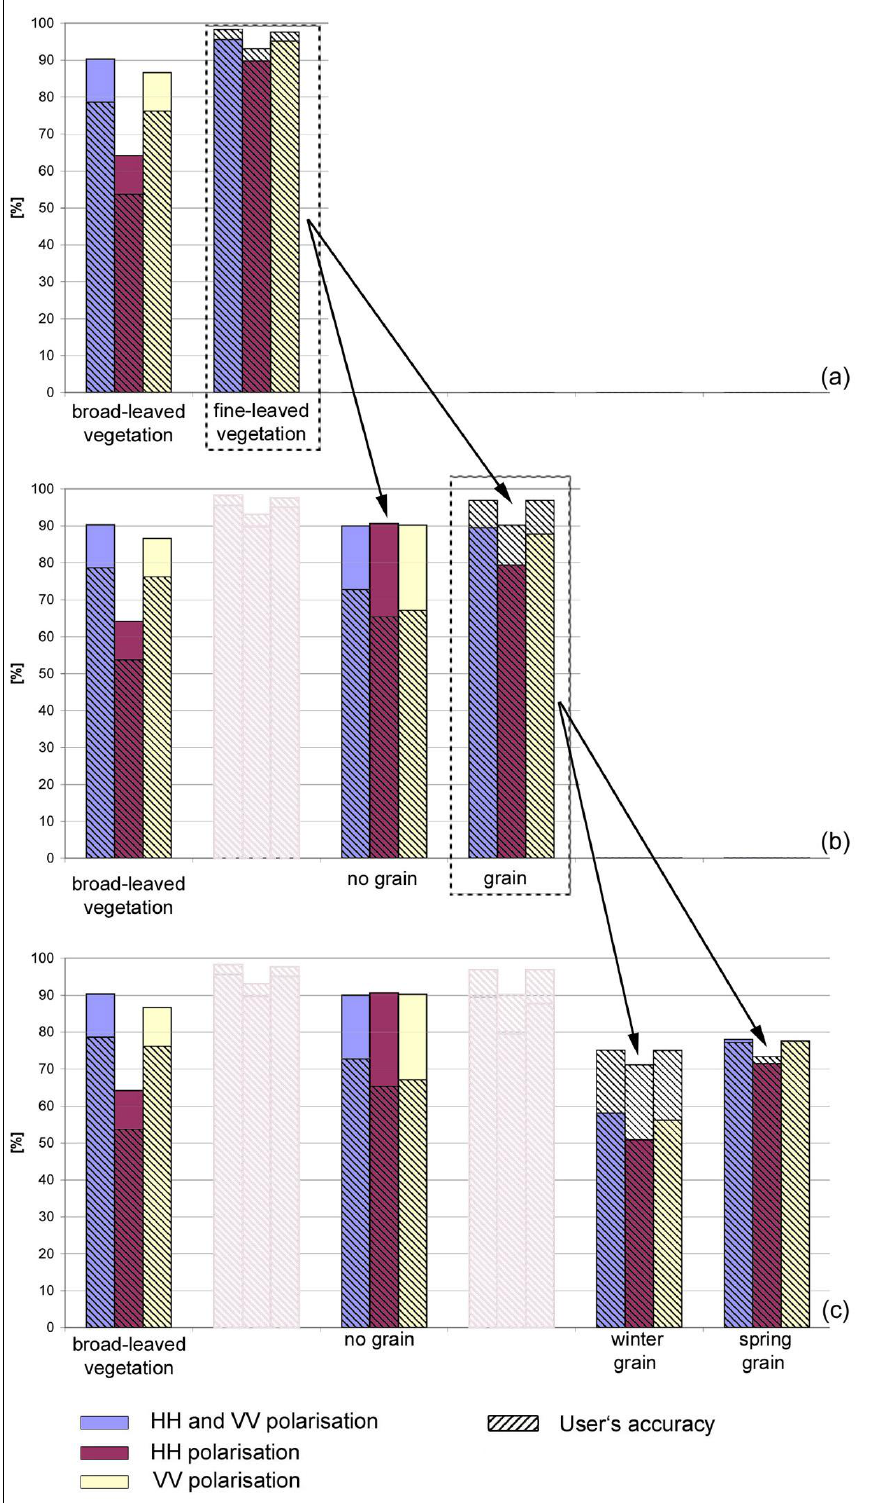
Figure 10. Classification accuracies for class groups in the Gorajec study area. (a) Overall accuracy for HH + VV polarization is 94.77% (Kappa coefficient is 0.84). For HH polarization values are 85.7% (0.66) and for VV polarization 93.87%, (0.81). (b) HH + VV: 89.69% (0.82), HH: 78.57% (0.68), VV: 87.93% (0.79) (c) HH + VV: 76.22% (0.71), HH: 67.7% (0.62), VV: 74.95%